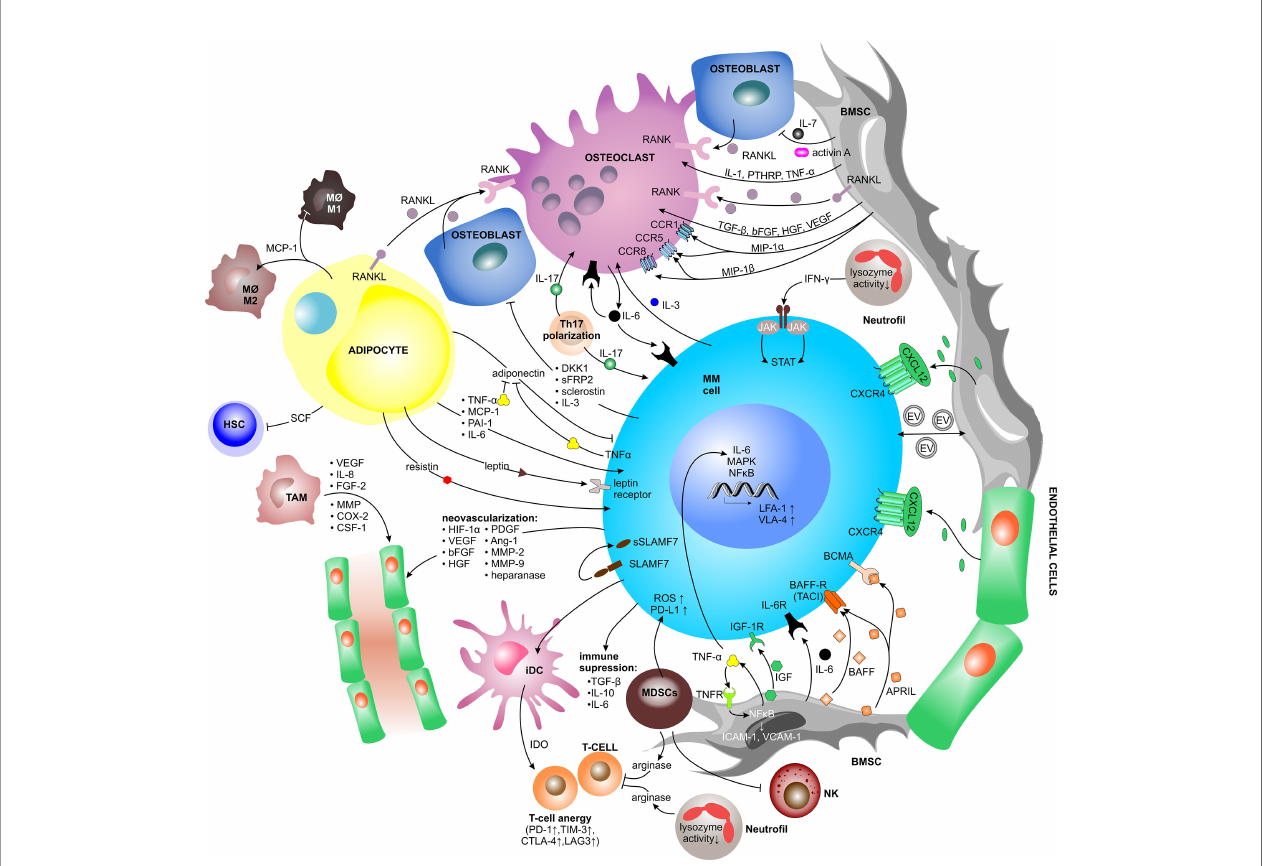
FIGURE 2 | Contact independent interactions between MM cells and the TME. Cellular crosstalk between MM cells and other key players of the TME triggering the release of soluble factors (mainly cytokines, chemokines, and growth factors, but also extracellular vesicles). Upon binding to their cognate receptors, soluble factors trigger intracellular signaling pathways, which promote myeloma growth and survival as well as BM neovascularization, bone remodeling and immune evasion. Ang-1, angiopoietin-1; APRIL, a proliferation-inducing ligand; BAFF(-R), B-cell activating factor(-receptor); BCMA, B-cell maturation antigen; bFGF, basic fi broblast growth factor; BMSC, bone marrow stromal cell; CCR, C-C motif chemokine receptor; COX-2, cycloxygenase-2; CSF-1, colony stimulating factor-1; CTLA-4, cytotoxic T lymphocyte antigen-4; CXCL, C-X-C motif chemokine ligand; CXCR, C-X-C motif chemokine receptor; DC, dendritic cell; DKK1, dickkopf WNT signaling pathway inhibitor 1; EV, extracellular vesicle; FGF-2, fi broblast growth factor-2; HGF, hepatocyte growth factor; HIF-1 a , hypoxia inducible factor-1 a ; HSC, hematopoietic stem cell; ICAM-1, intercellular adhesion molecule 1; iDC, immature dendritic cell; IDO, indoleamine 2,3-dioxygenase; IFN- g , interferon- g ; IGF, insulin- like growth factor; IGF-1R, insulin-like growth factor 1 receptor; IL, interleukin; JAK2, janus kinase2; LAG3, lymphocyte-activation gene 3; LFA-1, lymphocyte function associated-1; M F , macrophage; MAPK, mitogen-activated protein kinase; MCP-1, monocyte chemoattractant protein-1; MDSC, myeloid-derived suppressor cell; MIP-1 a /ß, macrophage in fl ammatory protein 1- a /ß; MM, multiple myeloma; MMP, matrix metalloproteinase; NF k B, nuclear factor kappa B; NK, natural killer cell; PAI-1, plasminogen activator inhibitor-1; PD-1, programmed cell death protein 1; PD-L1, programmed cell death 1 ligand 1; PDGF, platelet-derived growth factor; PTHRP, parathyroid hormone-related peptide; RANK(L), receptor activator of NF k B (ligand); ROS, reactive oxygen species; SCF, stem cell factor; sFRP2, secreted frizzled related protein 2; (s)SLAMF7, (secreted) signaling lymphocytic activation molecule family member 7; STAT, signal transducer and activator of transcription; TAM, tumor associated macrophage; TACI, transmembrane activator and CAML interactor; TGF-ß, transforming growth factor-ß; TIM-3, T-cell immunoglobulin and mucin-domain containing-3; TNF- a , tumor necrosis factors- a ; VCAM1, vascular cell adhesion molecule 1; VEGF, vascular endothelial growth factor; VLA-4, very late